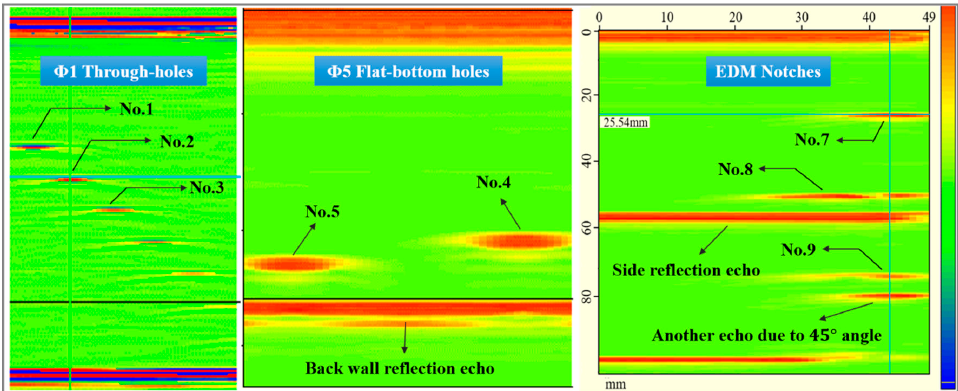
Figure 12. The real-time measurements of three kinds of defects.